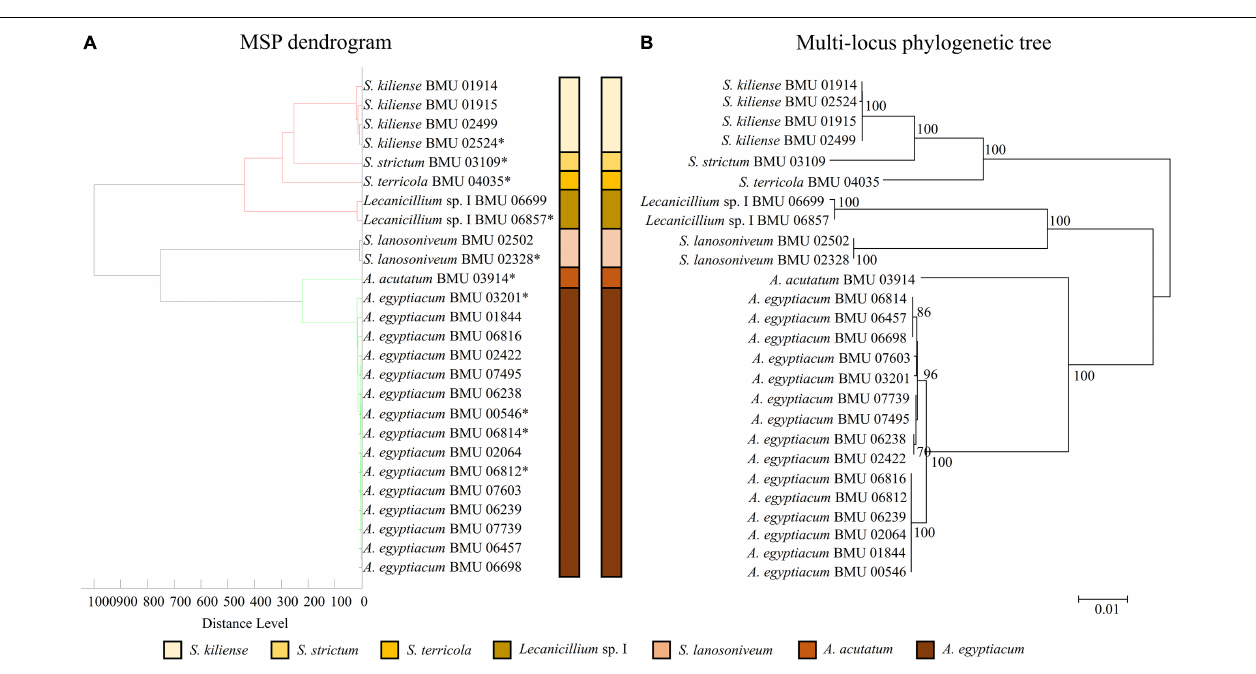
FIGURE 6 | (A) Main spectrum profile dendrogram of 26 Acremonium -like isolates based on MALDI-TOF MS analysis; (B) molecular phylogenetic tree generated by the NJ method from the combined ITS-LSU and EF1- α sequences of 26 Acremonium -like